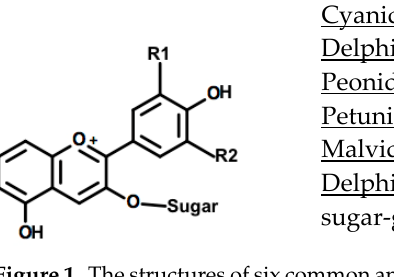
Figure 1. The structures of six common anthocyanins and one acylated anthocyanin, with the individual ring substituents listed below the flavylium ion backbone [9,16].